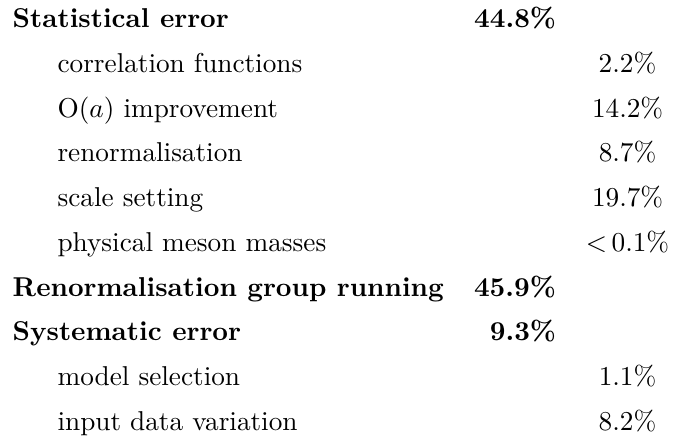
Table 3 . Error budget of our computation, quantified by the contributions to the squared error of our final estimate for M . We group them into the three main categories ‘Statistical error’, c ‘Renormalisation group running’ and ‘Systematic uncertainty’, which comprise the final (total) error, where the listed individual subcategories indicate how these uncertainties are distributed among the main